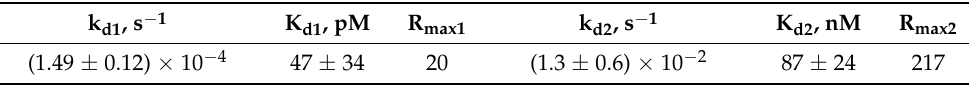
Figure 4. Kinetics of the interaction between IFN- β and Ca 2+ -bound S100B at 25 °C (1 mM CaCl 2 , pH 7.4), monitored by SPR spectroscopy using IFN- β as an analyte (10–80 nM) and S100B as a ligand. Grey curves are experimental, while black curves are theoretical, calculated according to the heterogeneous ligand model [1] (see Table 1 for the fitting parameters). Table 1. Parameters of the heterogeneous ligand model [1] describing the SPR data on kinetics of the IFN- β association with Ca 2+ -loaded S100B (Figure 4).